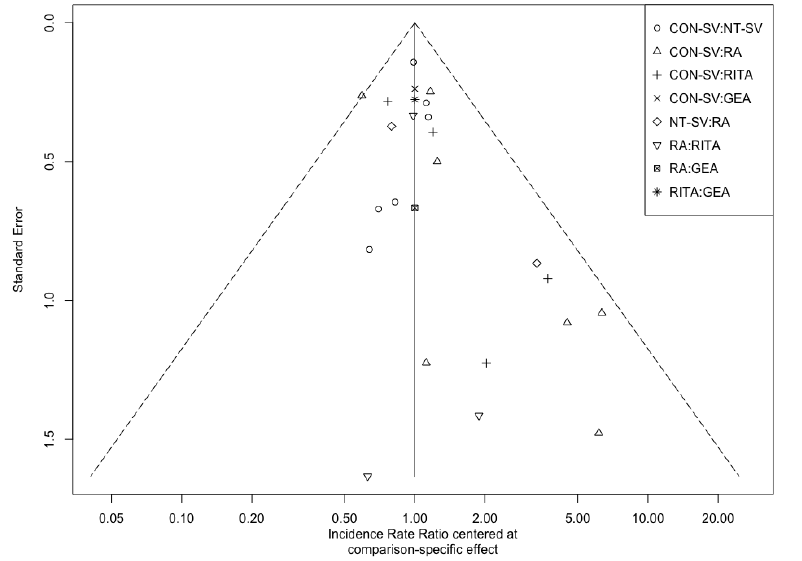
Fig. S7 - Funnel plot for all studies. CON-SV=conventionally harvested saphenous vein; GEA=gastroepiploic artery; NT-SV=no-touch saphenous vein; RA=radial artery; RITA=right internal thoracic